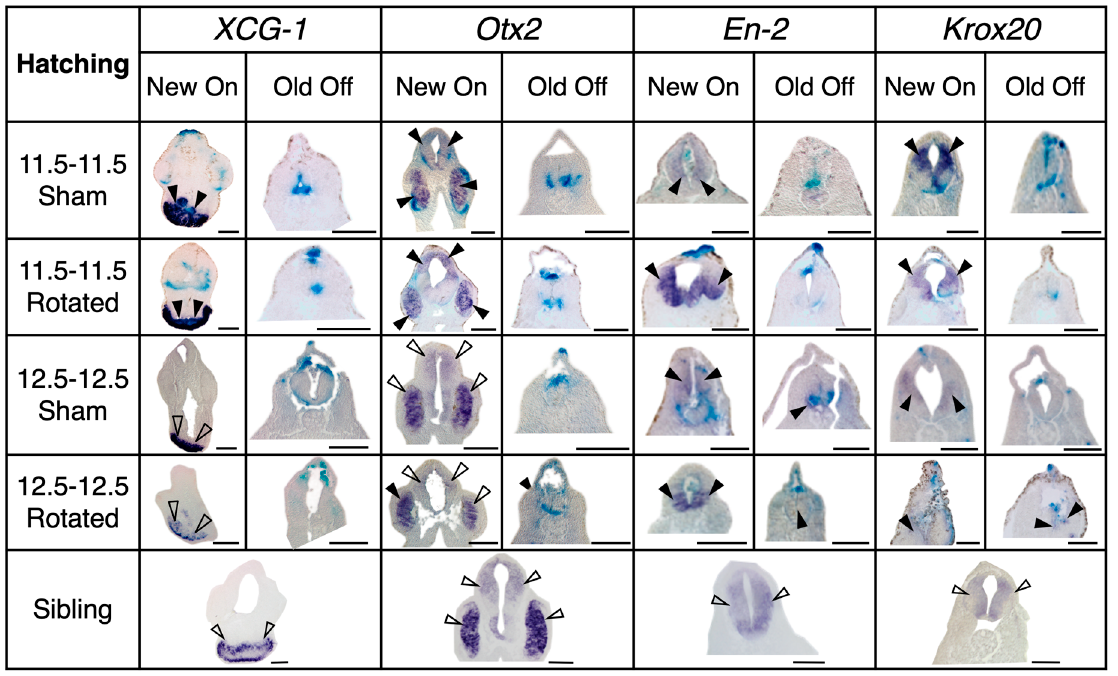
Figure 9. Representative histology for transplants at hatching stage, with sibling control comparisons. Dorsal is facing up. Purple stain marked with a solid arrowhead indicates gene expression colocalized with transplant tissue, purple stain marked with an empty arrowhead indicates endogenous gene expression, and blue stain indicates transplant incorporation. Late gastrula rotated embryos show decreased levels of and more restricted area of marker gene expression at correct places compared with mid-gastrula sham and rotated embryos. Late gastrula rotated embryos also present more ectopic gene expression than mid-gastrula rotated embryos. Scale bar represents 250 μ m.